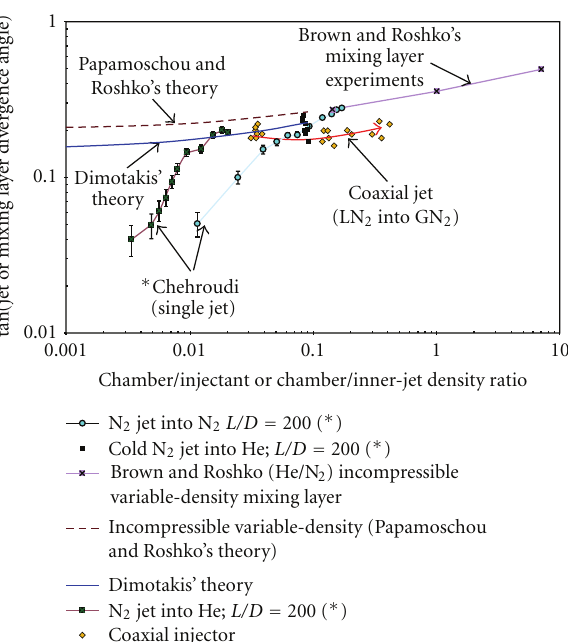
Figure 25: Spreading rate of the shear layer versus the cham- ber/injectant or chamber/inner-jet density ratio for single and coaxial jets compared with di ff erent predictions for planar shear layers. For the coaxial data, the chamber pressure increases from sub- to near- and to supercritical conditions in the direction of the